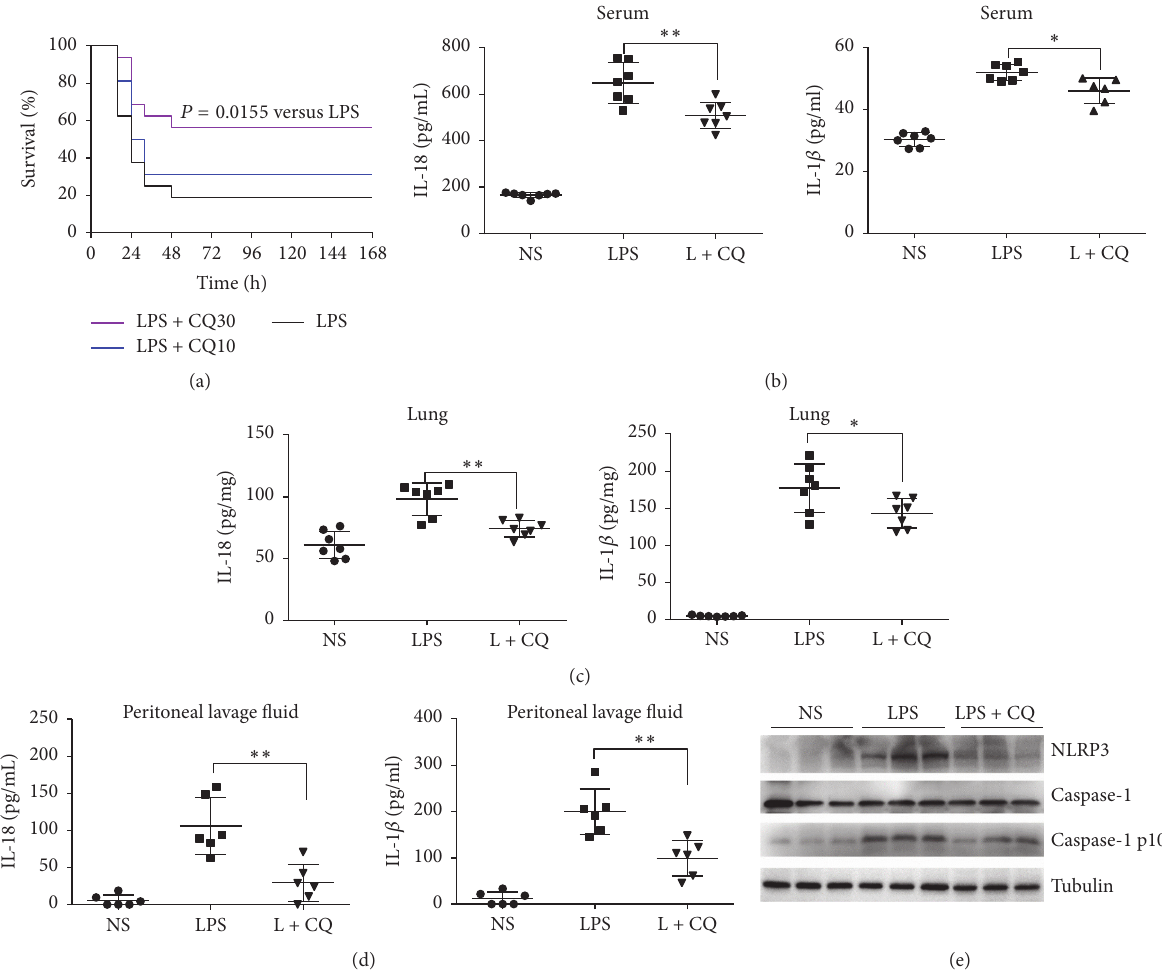
Figure 6: CQ protects mice against lethal endotoxic shock by suppressing NLRP3 inflammasome activation. CQ improved survival in endotoxic shock murine model. BALB/c murine mice ( 𝑛 = 16 per group) were injected with a lethal dose of LPS (15mg/kg) alone or together with CQ (10, 30mg/kg). (a) Survival in each group was observed for 168 h and the log-rank test was used for intergroup comparison. ∗ 𝑃 < 0.05 versus LPS group. (b) IL-18 and IL-1 𝛽 levels in serum at 6h were measured by ELISA. (c) IL-18 and IL-1 𝛽 levels in lung homogenates at 6h were measured by ELISA ( 𝑛 = 7 per group). (d) IL-18 and IL-1 𝛽 levels in peritoneal lavage fluid at 6 h were measured by ELISA ( 𝑛 = 6 per group). Data are shown as means ± SEM. ∗ 𝑃 < 0.05 , ∗∗ 𝑃 < 0.01 versus LPS group. (e) Caspase-1 activation and NLRP3 expression in the lung were detected by western blot ( 𝑛 = 3